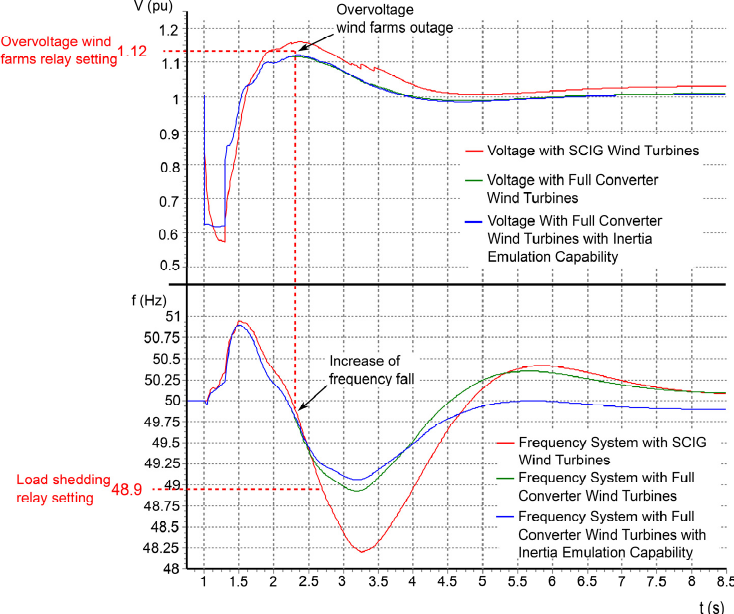
Figure 13. Time evolution of voltage and frequency for a 300 ‐ ms three ‐ phase short circuit at the Las Salinas bus with 80 MW of total wind